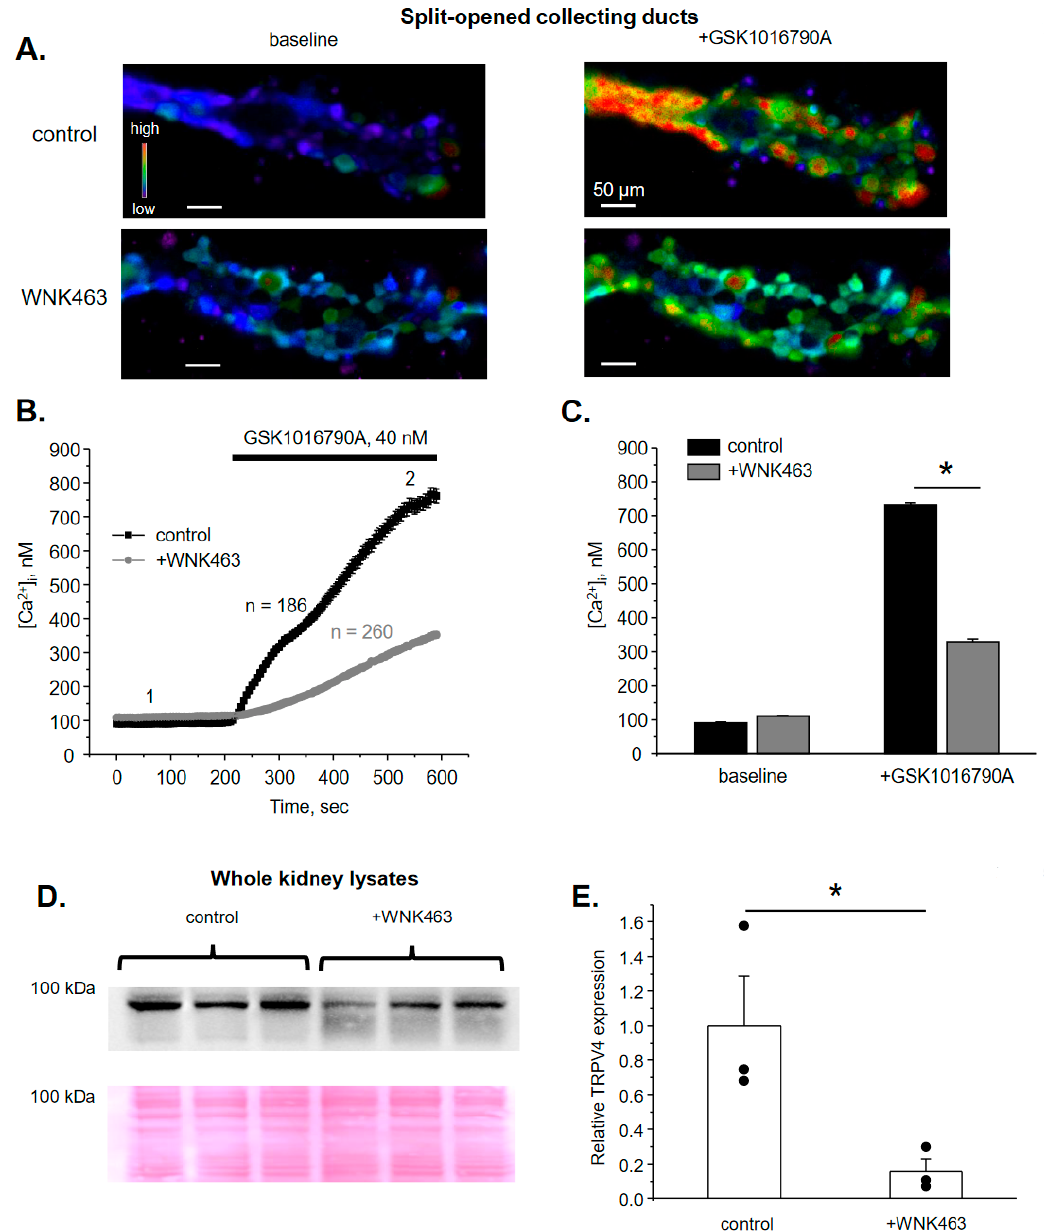
Figure 1. WNK inhibition decreases TRPV4 activity and expression in ASDN. ( A ) Representative pseudo-color images of [Ca 2+ ] i changes (blue—low and red—high) in isolated split-opened collecting ducts loaded with Ca 2+ -sensitive dye Fura2 at the baseline (left) and following 5 min application of TRPV4 agonist, GSK1016790A (right) from control (top) and WNK463 treated (bottom) mice. ( B ) The averaged time-courses of [Ca 2+ ] i changes upon application of 40 nM GSK1016790A (shown with the bar on top) in individual collecting duct cells within split-opened area from control and WNK463 treated mice. The time-points 1 (baseline) and 2 (GSK1016790A) represent conditions shown in panel (A). ( C ) Summary graph comparing [Ca 2+ ] i values in individual collecting duct cells from control and WNK463 treated mice at the baseline and after GSK1016790A application. *—significant difference ( p < 0.05) between groups indicated with a line. ( D ) Actual Western blot probed with anti-TRPV4 antibodies from whole kidney lysates from mice kept on standard conditions (control) or treated with WNK463. The Ponceau red staining of the same nitrocellulose membrane demonstrating equal protein loading is shown on the bottom panel. ( E ) Summary graph comparing TRPV4 expression levels in the conditions from panel ( D ). The intensity values were normalized to the total signal of the respective lines in Ponceau red staining. *—significant differences ( p < 0.05).